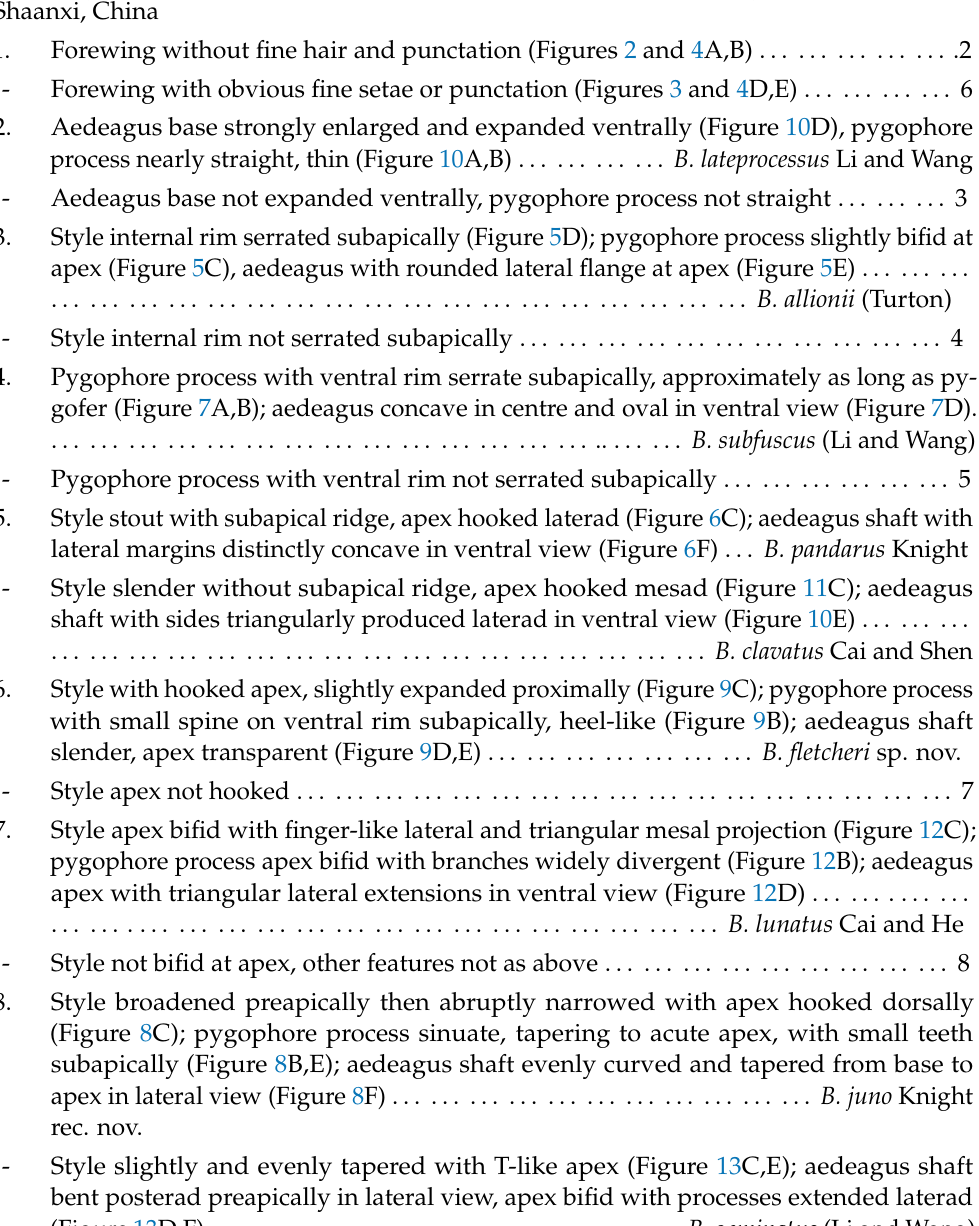
4. Pygophore process with ventral rim serrate subapically, approximately as long as py- gofer (Figure 7A,B); aedeagus concave in centre and oval in ventral view (Figure 7D). Pygophore process with ventral rim not serrated subapically . . . . . . . . . . . . . . . . . . 5 5. Style stout with subapical ridge, apex hooked laterad (Figure 6C); aedeagus shaft with lateral margins distinctly concave in ventral view (Figure 6F) . . . B. pandarus Knight - Style slender without subapical ridge, apex hooked mesad (Figure 11C); aedeagus shaft with sides triangularly produced laterad in ventral view (Figure 10E) . . . . . . . . . . . . . . . . . . . . . . . . . . . . . . . . . . . . . . . . . . . . . . . . . . . . . . . . . . . . B. clavatus Cai and Shen 6. Style with hooked apex, slightly expanded proximally (Figure 9C); pygophore process with small spine on ventral rim subapically, heel-like (Figure 9B); aedeagus shaft slender, apex transparent (Figure 9D,E) . . . . . . . . . . . . . . . . . . . . . B. fletcheri sp. nov. 7. Style apex bifid with finger-like lateral and triangular mesal projection (Figure 12C); pygophore process apex bifid with branches widely divergent (Figure 12B); aedeagus apex with triangular lateral extensions in ventral view (Figure 12D) . . . . . . . . . . . . . Style not bifid at apex, other features not as above . . . . . . . . . . . . . . . . . . . . . . . . . . . 8 8. Style broadened preapically then abruptly narrowed with apex hooked dorsally (Figure 8C); pygophore process sinuate, tapering to acute apex, with small teeth subapically (Figure 8B,E); aedeagus shaft evenly curved and tapered from base to apex in lateral view (Figure 8F) . . . . . . . . . . . . . . . . . . . . . . . . . . . . . . . . . B. juno Knight rec. nov. Style slightly and evenly tapered with T-like apex (Figure 13C,E); aedeagus shaft bent posterad preapically in lateral view, apex bifid with processes extended